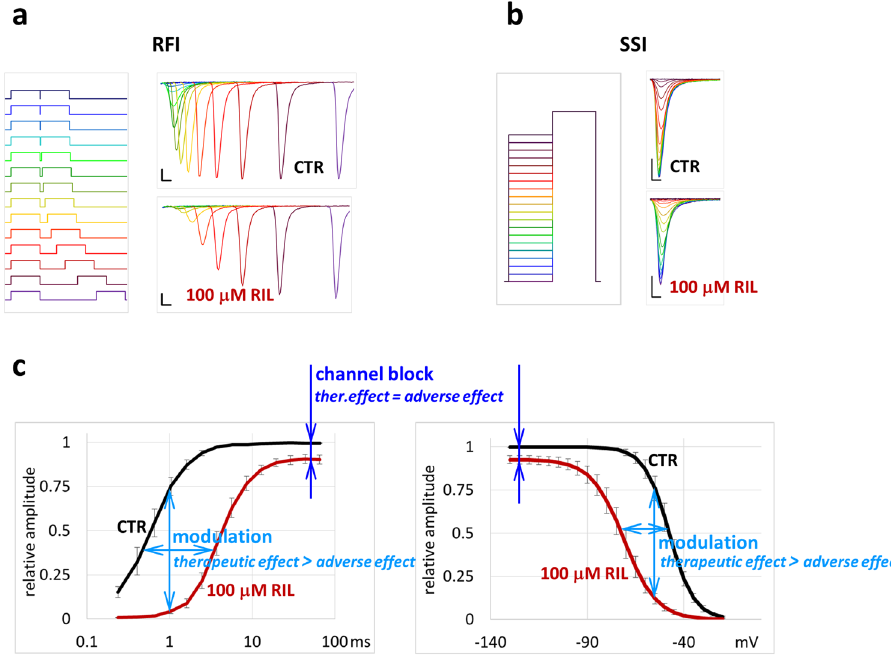
Figure 1. The extent of channel block and modulation can be assessed using RFI and SSI protocols. ( a ) Illustration of the first 22 ms of the RFI protocol. Left panel indicates the arrangement of 10 ms long depolarizing pulses ( − 130 to − 10 mV), right panel illustrates currents evoked by the 2 nd pulse in a cell in control solution and in the presence of riluzole, on linear time scale. Scale bars: 1 ms and 1 nA. ( b ) Illustration of the SSI protocol. Left panel shows the voltage protocol (10 ms pre-pulses from − 130 to − 20 mV in 5 mV increments, followed by a 10 ms test pulse to − 10 mV). Right panel shows examples for currents evoked by the test pulse in control solution and in the presence of riluzole. ( c ) Assessment of channel block and modulation using the RFI (plotted on a logarithmic time scale) and SSI protocols. Amplitudes were normalized to the maximum amplitude of control; mean amplitudes were obtained as described in text. Resting channel block is observed when sufficient time has been spent at hyperpolarized membrane potential. The effect of modulation is seen by the shift of